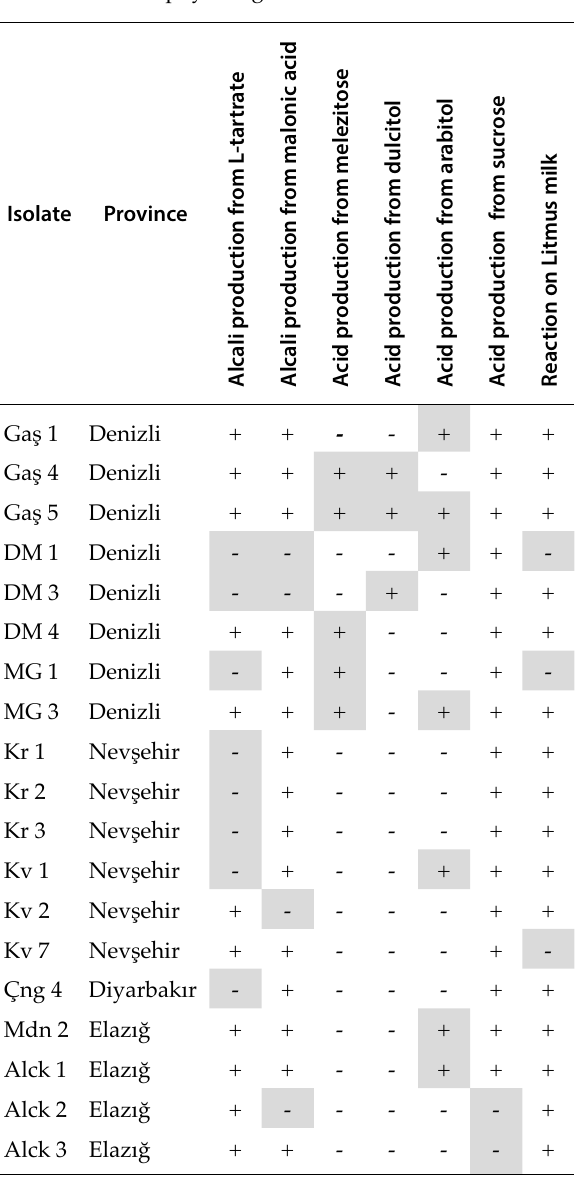
In grey are highlithed the anomalous